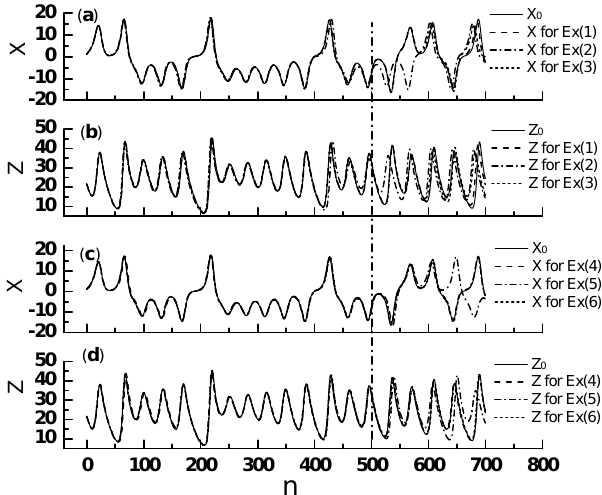
Fig. 2. The “observed value” ( x 0 ,z 0 ) and the corresponding predic- tion data ( x,z ) of the prediction model, where the sample size is 700. (a) Variable x in the Lorenz model; and (b) variable z in the Lorenz model.